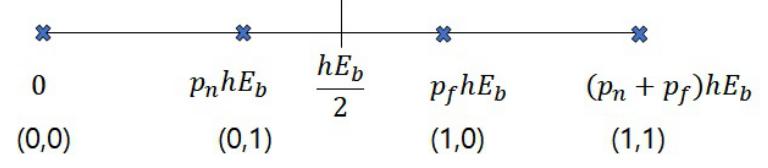
Figure 2. The constellation for the received